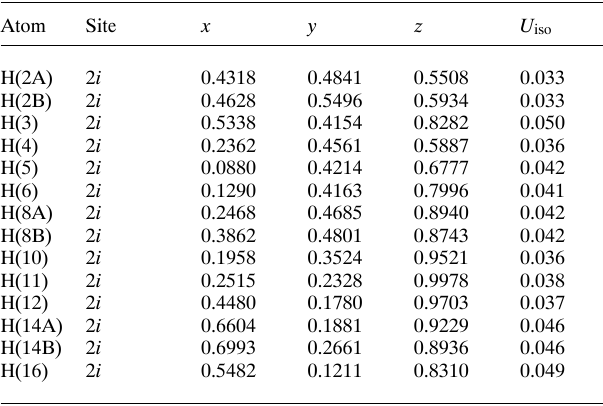
Table 2. A tomic coordin a tes a nd displ a cement p a r a meters (in Å 2 )